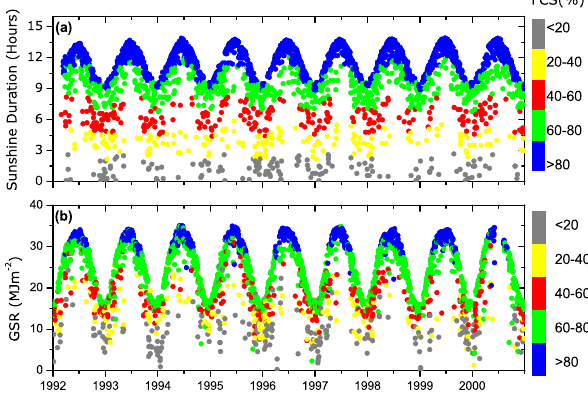
Table 3. Coefficients a and b between 1992 and 1996 for five FCS intervals.